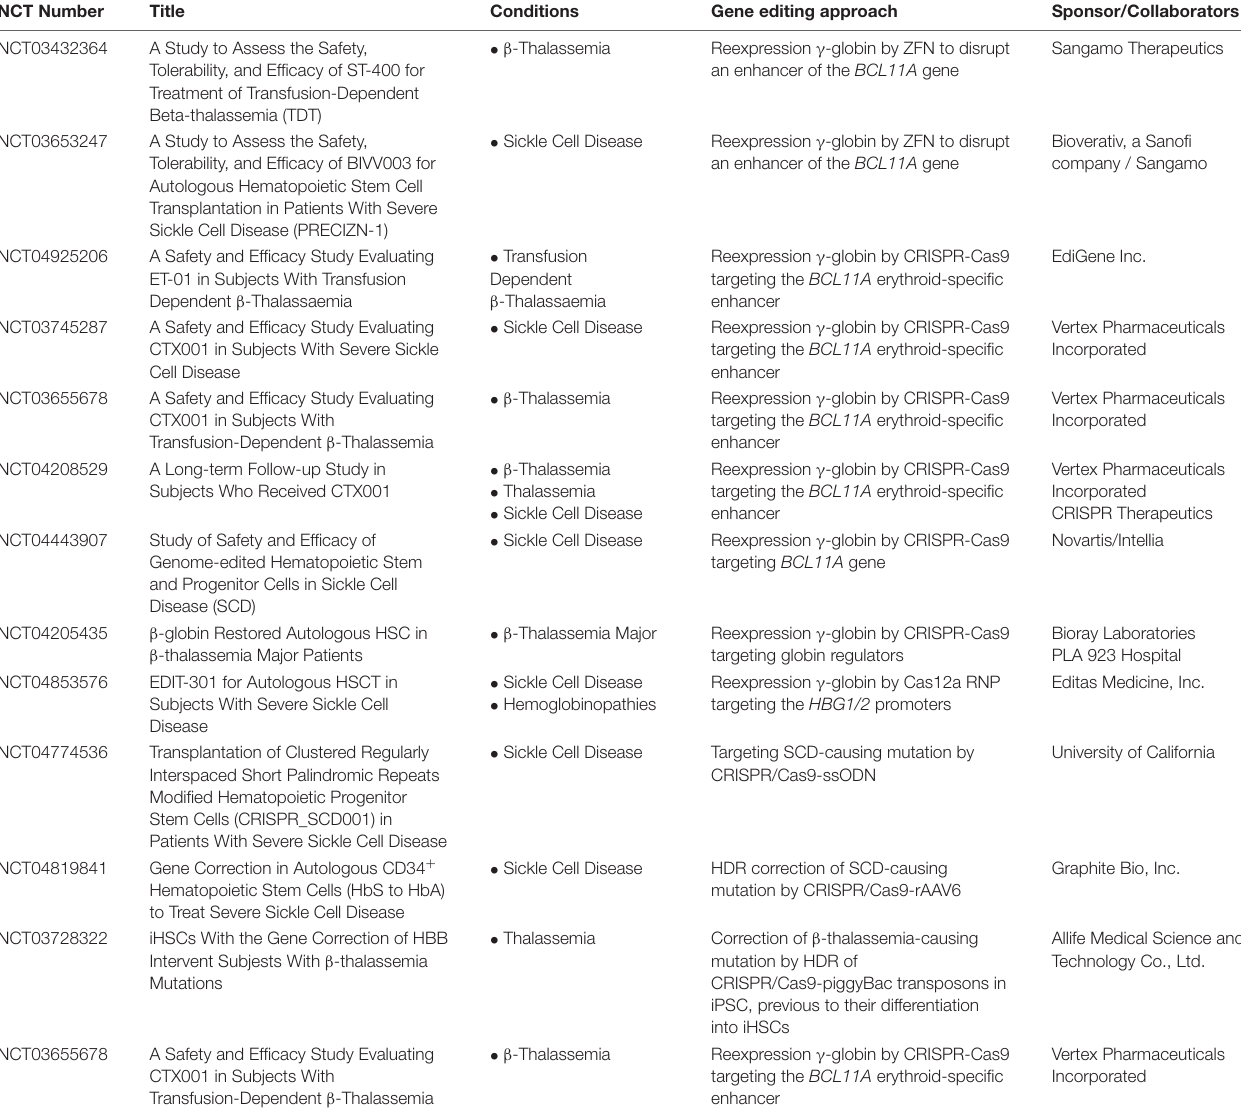
TABLE 1 | Gene editing clinical trials for hemoglobinopathies updated as of December